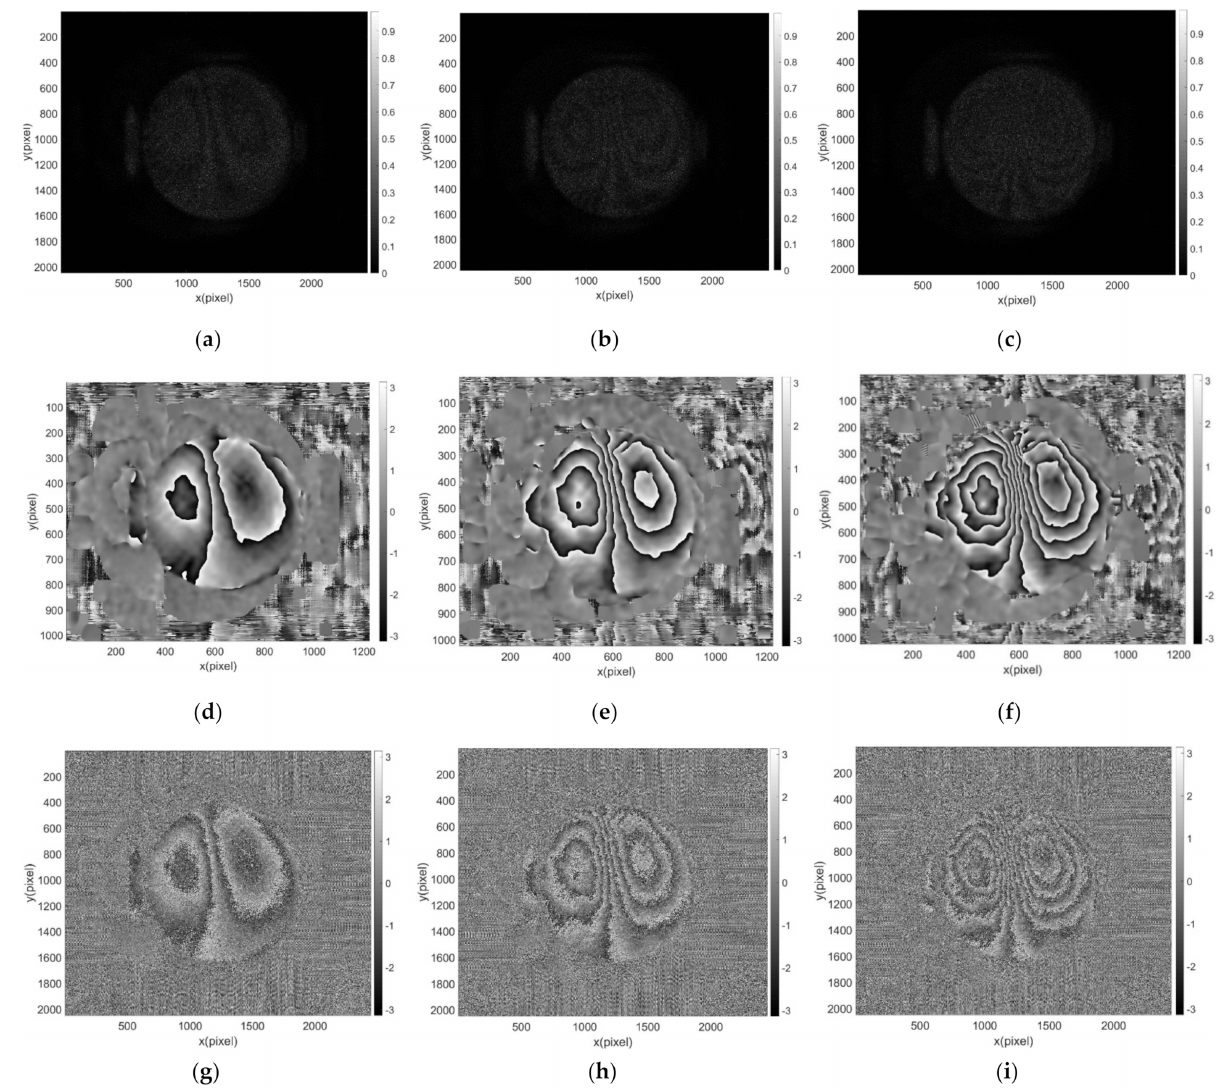
Figure 10. Results derived at three time instants for defect 1 on the WTB; ( a – c ) Fringe patterns at time instants of 65th frame, 130th frame, and 200th frame; ( d – f ) Phase maps derived with the proposed method at time instants of 65th frame ( . . ∆ φ ∆ φ 130th frame ( t 130 ), and 200th frame ( t 200 ); ( g – i ) Phase maps without passing through WFF filter at time instants of 65th frame ( ∆ φ t ), 130th frame ( ∆ φ t ), and 200th frame ( ∆ φ t 65 200 130